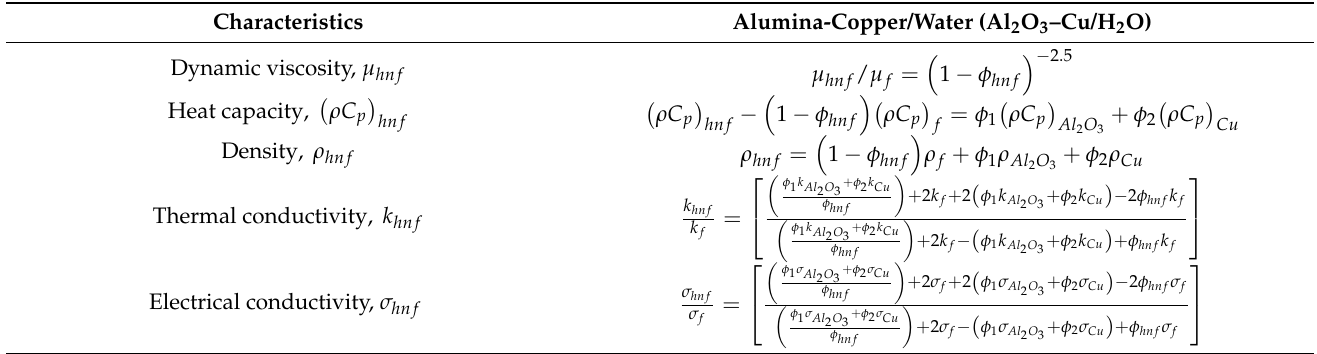
Table 1. Correlations of hybrid nanofluid (see Takabi and Salehi [40]).